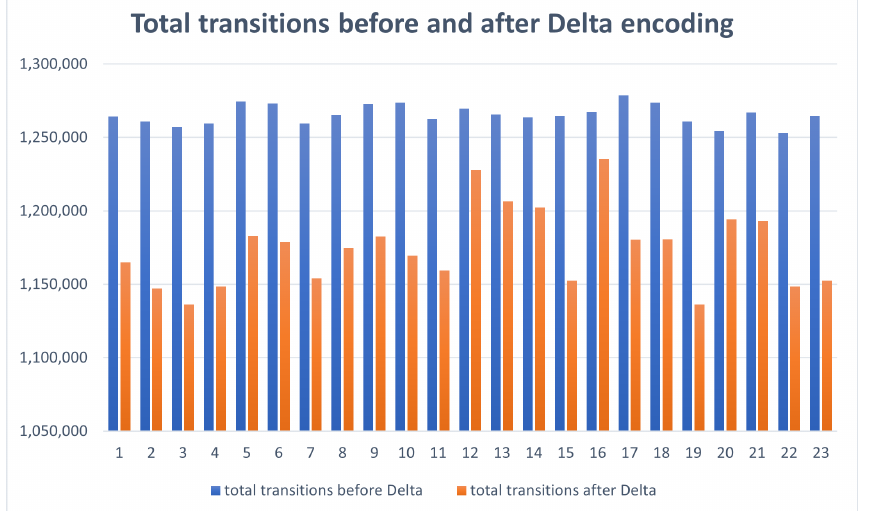
Figure 4. Bar chart of 0-0, 0-1, 1-0, and 1-1 transitions before and after Delta encoding for all the leads examined.